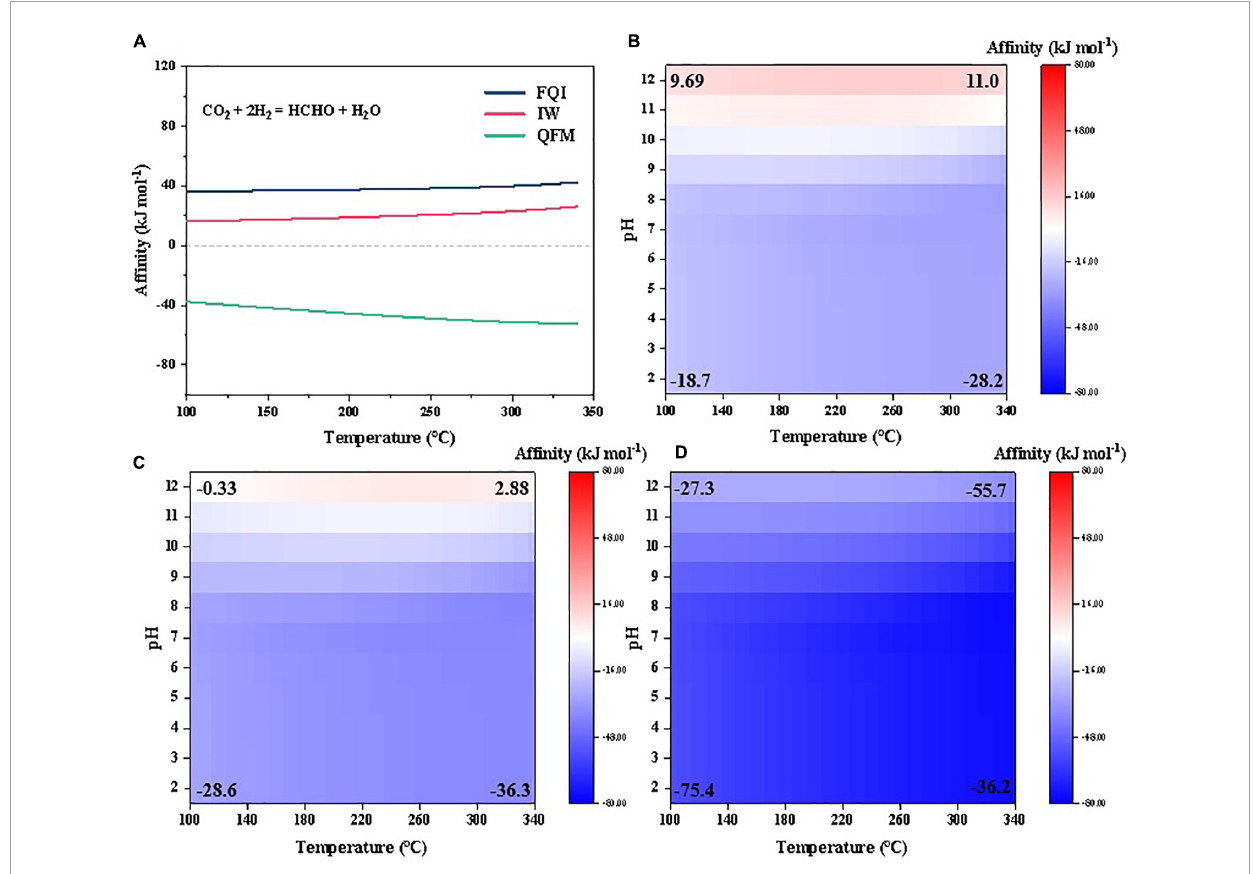
FIGURE8 Synthesis affinity of (A) formaldehyde, (B–D) cyanide at different redox states [ (B) , FQI; (C) , IW; (D) , FMQ] using CO 2 as the carbon source.